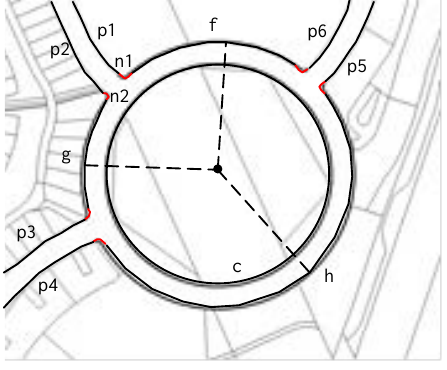
Figure 5. Spatial reasoning for a roundabout